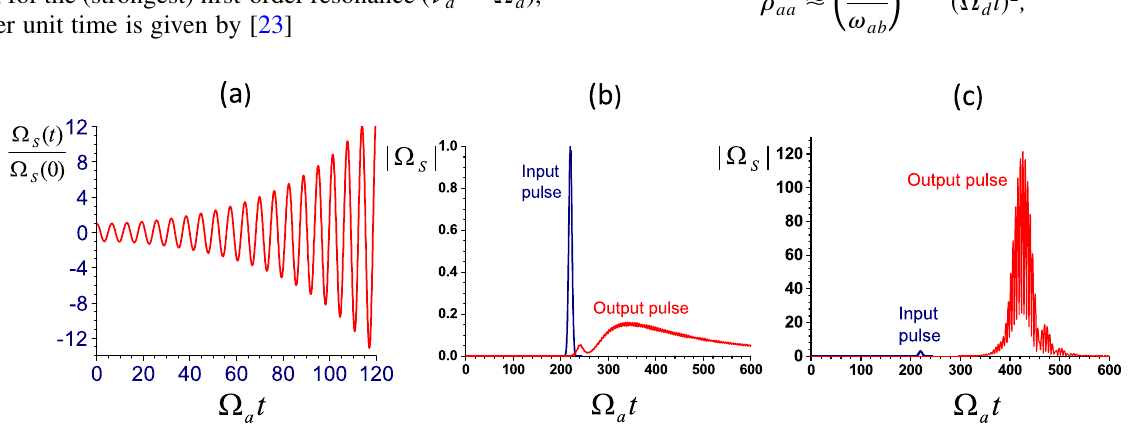
~ ¼ ~(cid:4) (cid:7) ¼ 0 : 1 , (cid:3) and initial d a